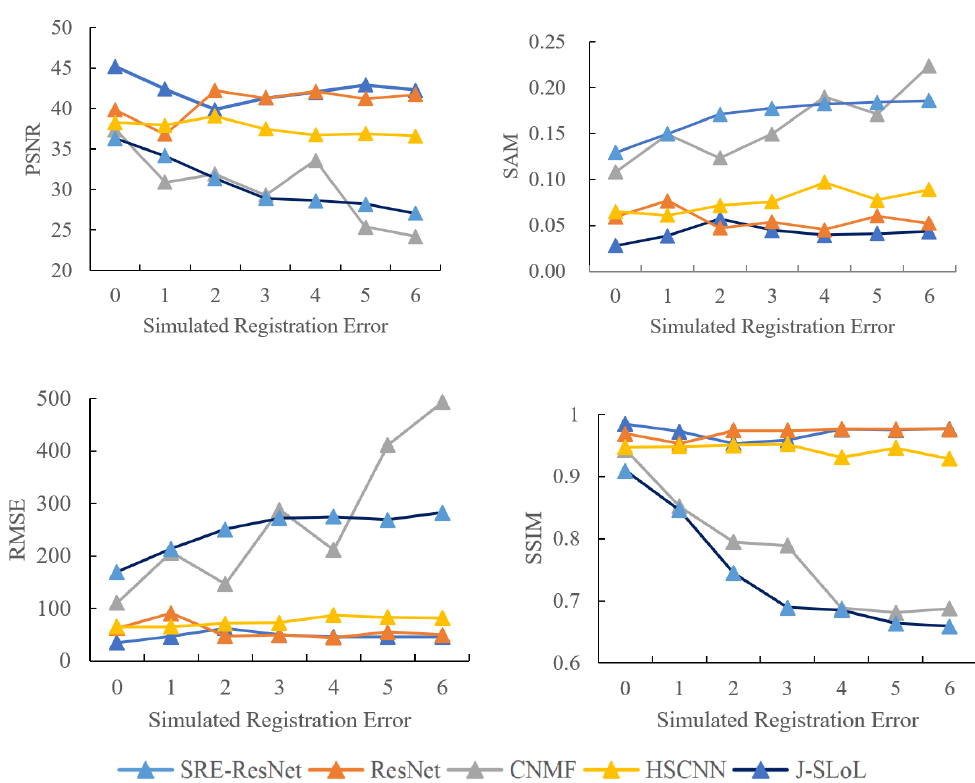
Figure 11. Quality assessment result of Dataset I with different simulated registration error.